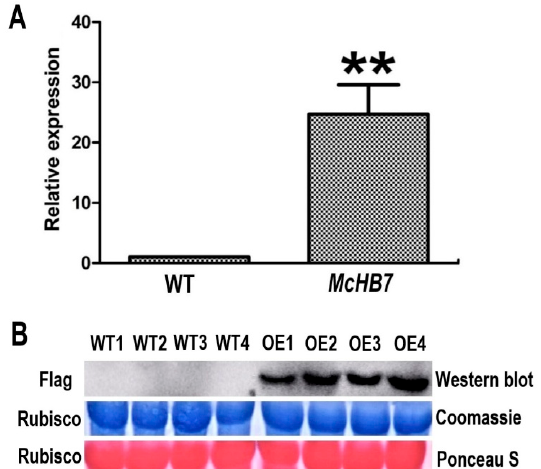
Figure 4. Overexpression of McHB7 in ice plants at day 7 after transformation. ( A ) The relative expression of McHB7 in the overexpression (OE) plants compared to WT; Student’s t -test, ** p < 0.01. Error bars indicate mean ± SD ( n = 4). ( B ) Images of Western blot showing Flag signal of McHB7 protein level in the OE plants. The protein loading was assessed by Coomassie staining and Ponceau S staining of Rubisco, showing equal loading. WT1–WT4 are four replicates of WT, OE1–OE4 are four replicates of McHB7 -over-expressing seedlings.